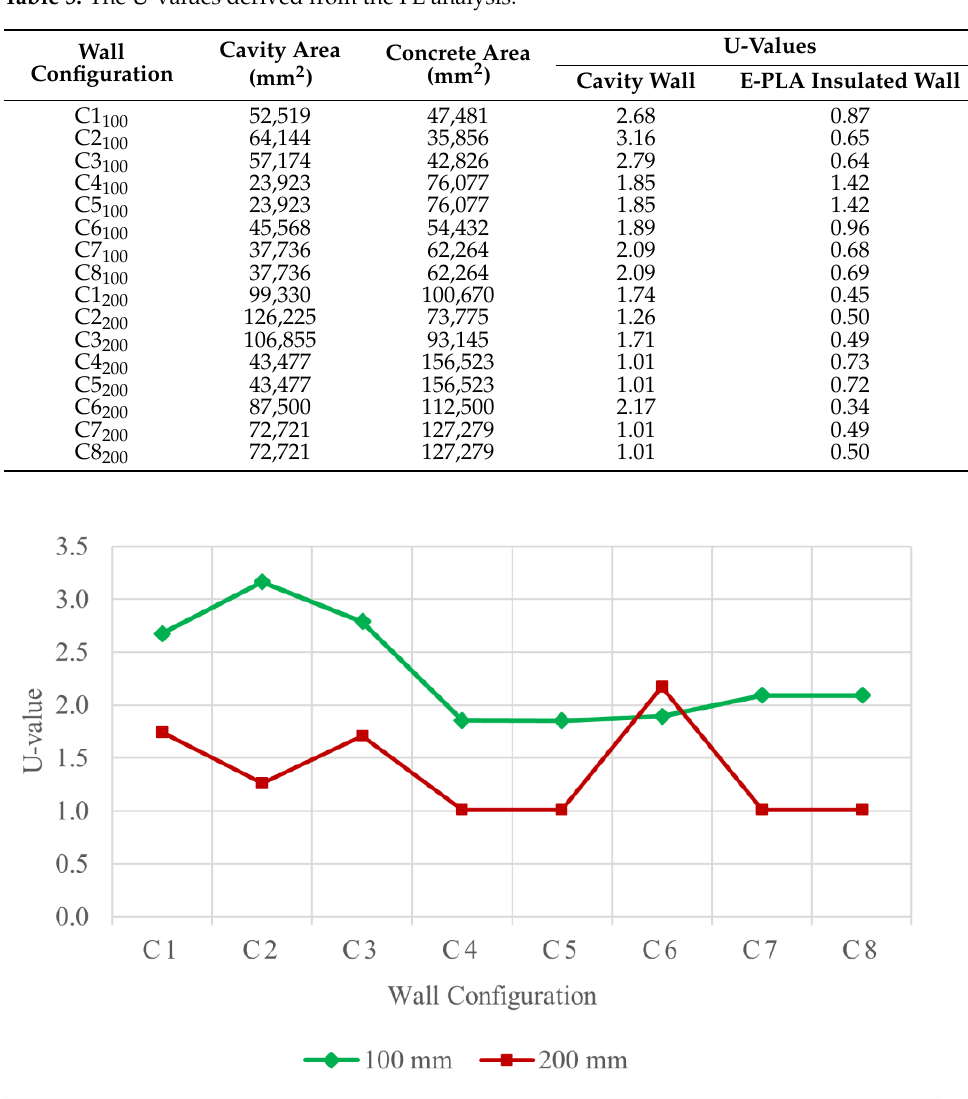
Table 5. The U-values derived from the FE analysis.